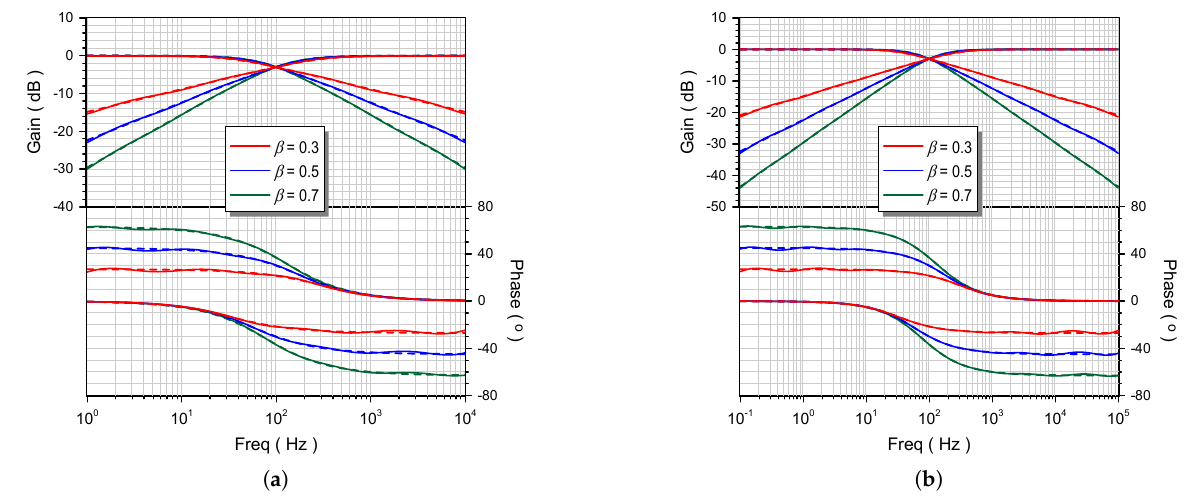
(cid:2) (cid:3) 10 − 1 ,10 + 5 Hz.